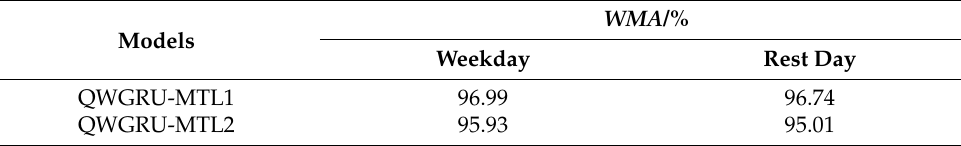
Table 4. Comparison of two multi-task learning models.